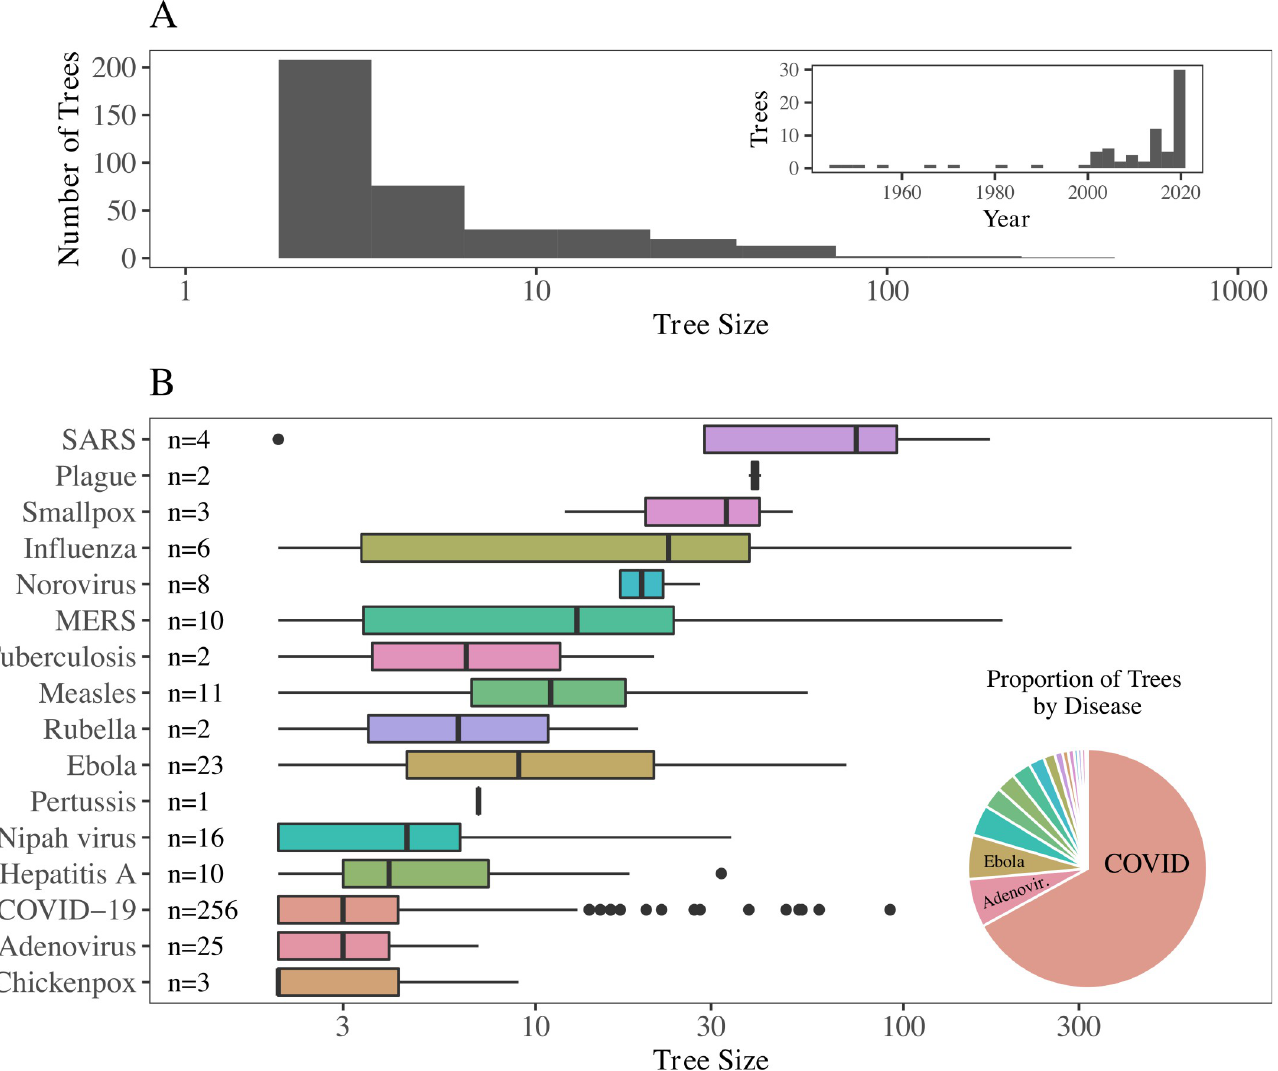
Fig 2. Characteristics of transmission trees in OutbreakTrees. (A) Tree size varies from 2 to 286 with a median of 3 and most trees represent outbreaks taking place in the past 20 years (only trees with 10 or more cases shown in date plot due to large number of small COVID-19 trees from 2020). (B) The largest trees are from H1N1 and SARS outbreaks, while the highest proportion of trees in the database are from outbreaks of COVID-19, followed by adenovirus and Ebola. Tree size axes in both plots are shown on a log 10 scale to better illustrate variation in medium-sized trees. All trees are used in this analysis. The data to reproduce this figure can be found at https://doi.org/10.5061/dryad.nk98sf7w7. COVID-19, Coronavirus Disease 2019; MERS, Middle East Respiratory Syndrome; SARS, Severe Acute Respiratory Syndrome.